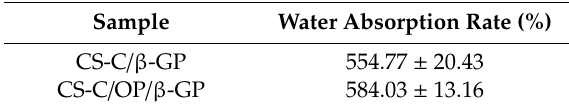
Table 1. Water absorption rate of freeze-dried hydrogels.